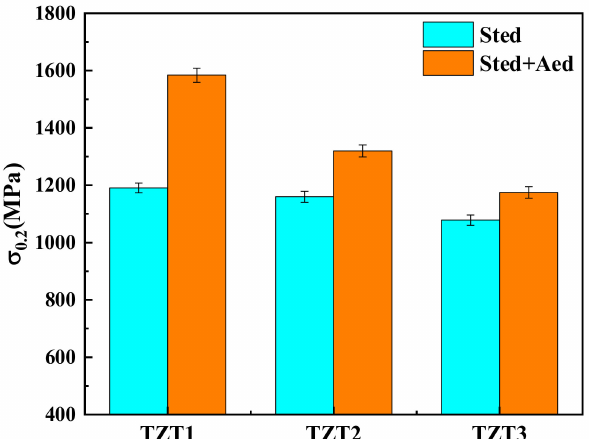
Figure 6. The yield strength of the TZT1 and TZT2 and TZT3 alloys after solution treatment at 1173 K for 3 h and age treatment at 973 K for 6